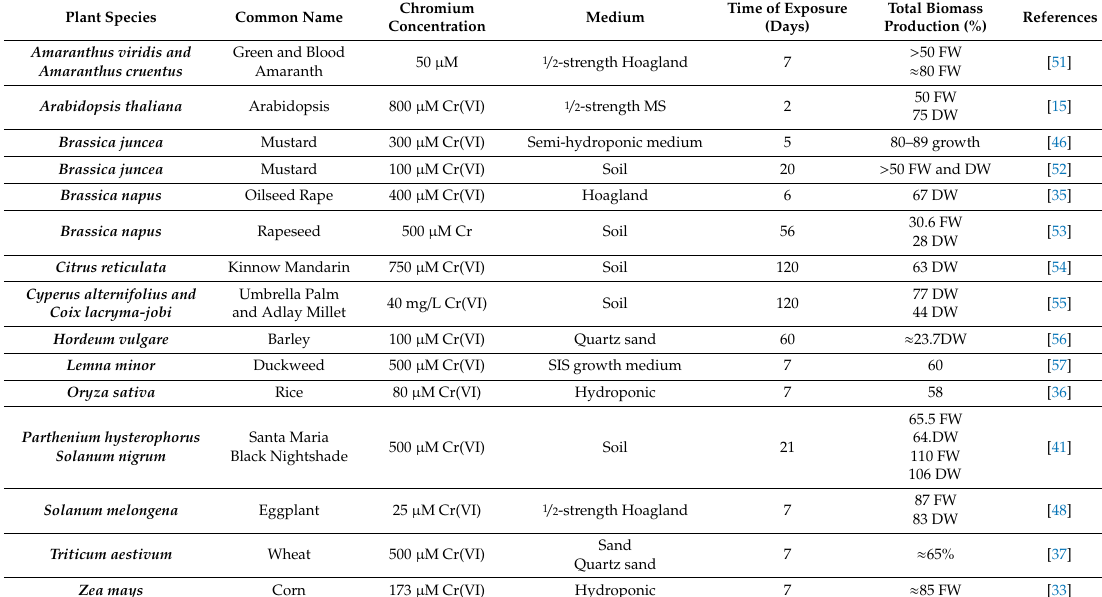
Table 5. Chromium-meditated reduction in the total plant biomass as compared to control in various plant